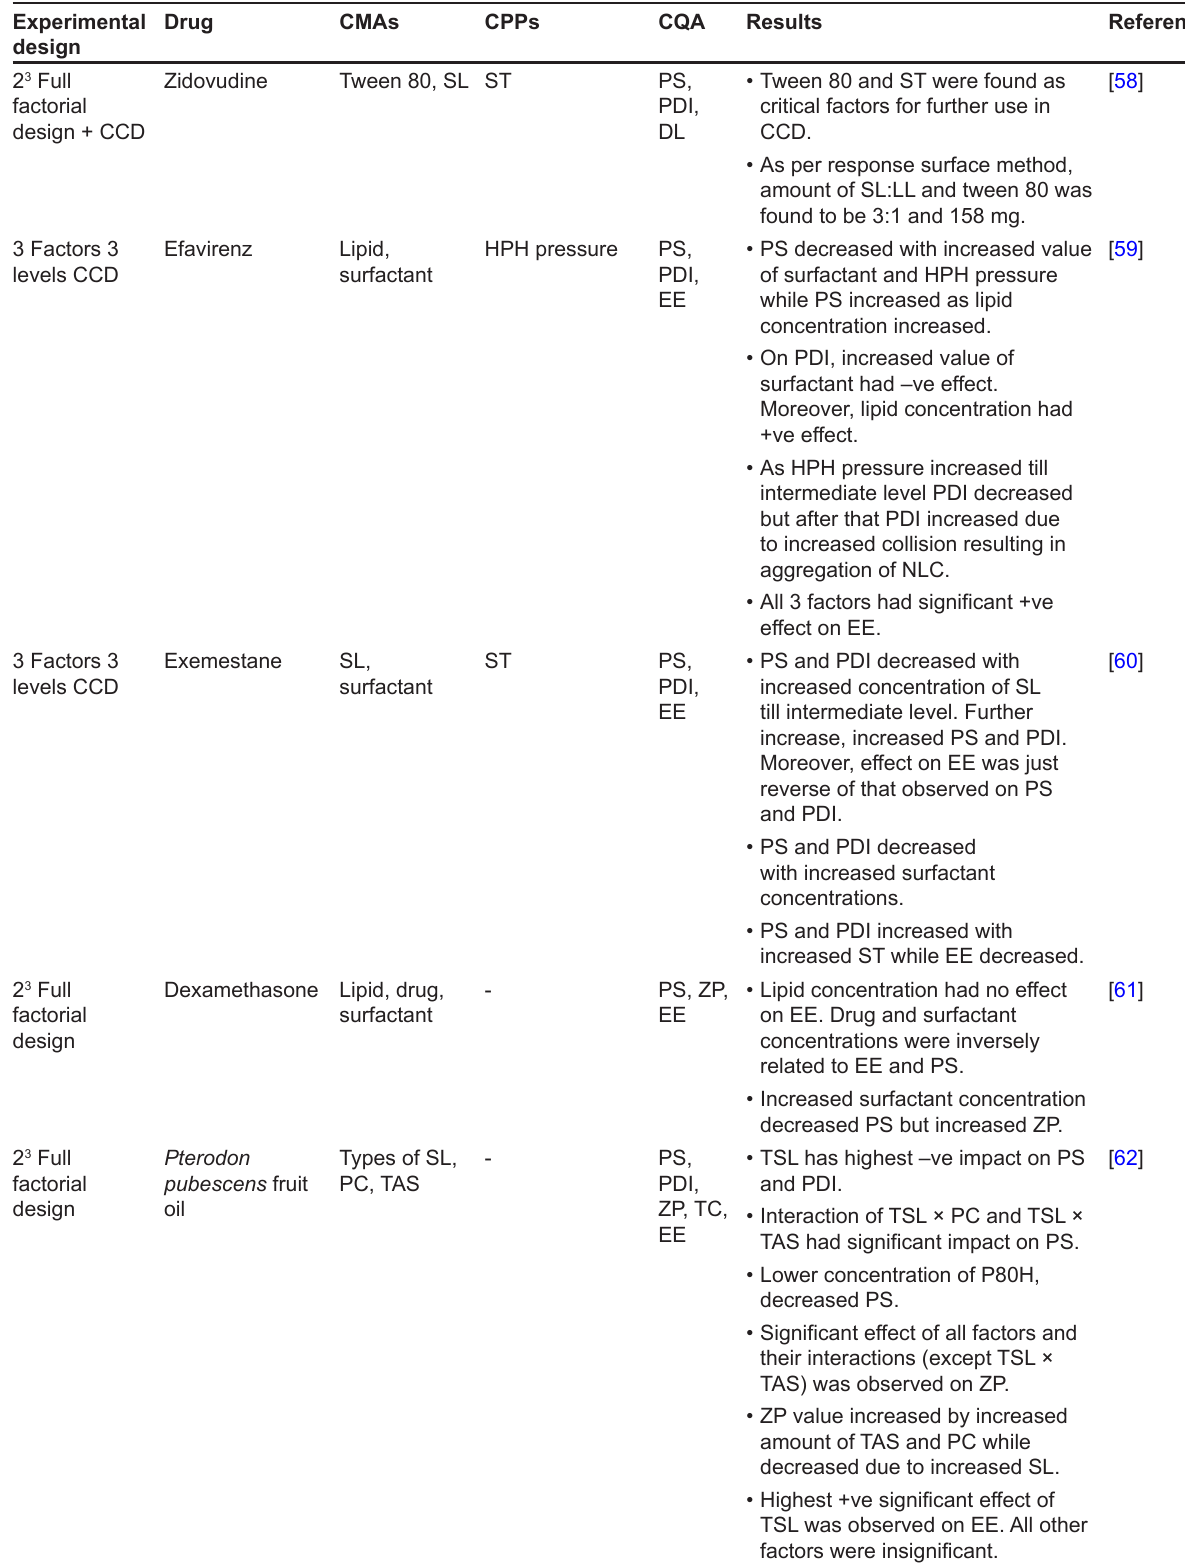
Table 4. Summary of optimization results by the application of QbD on NLC ( Continued )